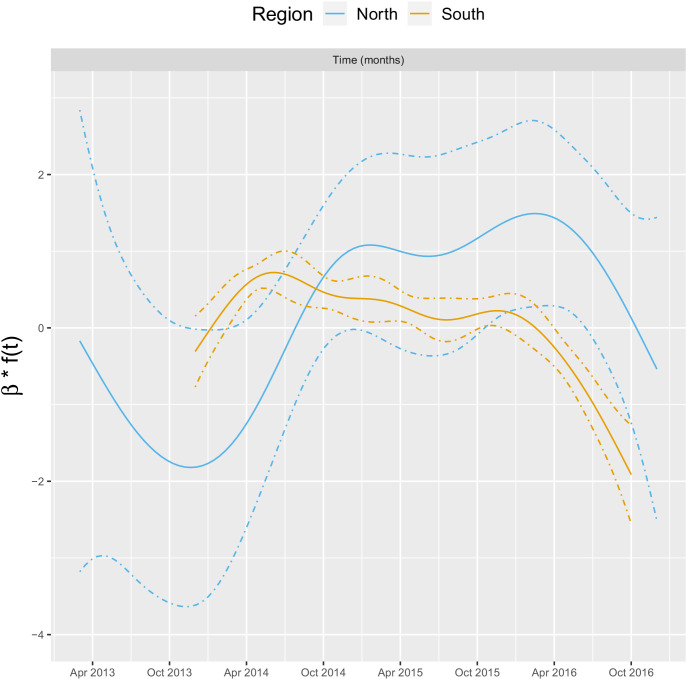
Relationships between malaria incidence and the temporal trend in the multivariable model described in equation 2 (30 km radius and - year temporal lag), additionally adjusted for the probability of seeking treatment, the spatial structure of the data (f⁢(L⁢a⁢t,L⁢o⁢n⁢g) and village random intercepts) and malaria incidence in the previous 1 and 2 months.See Materials and methods for details.